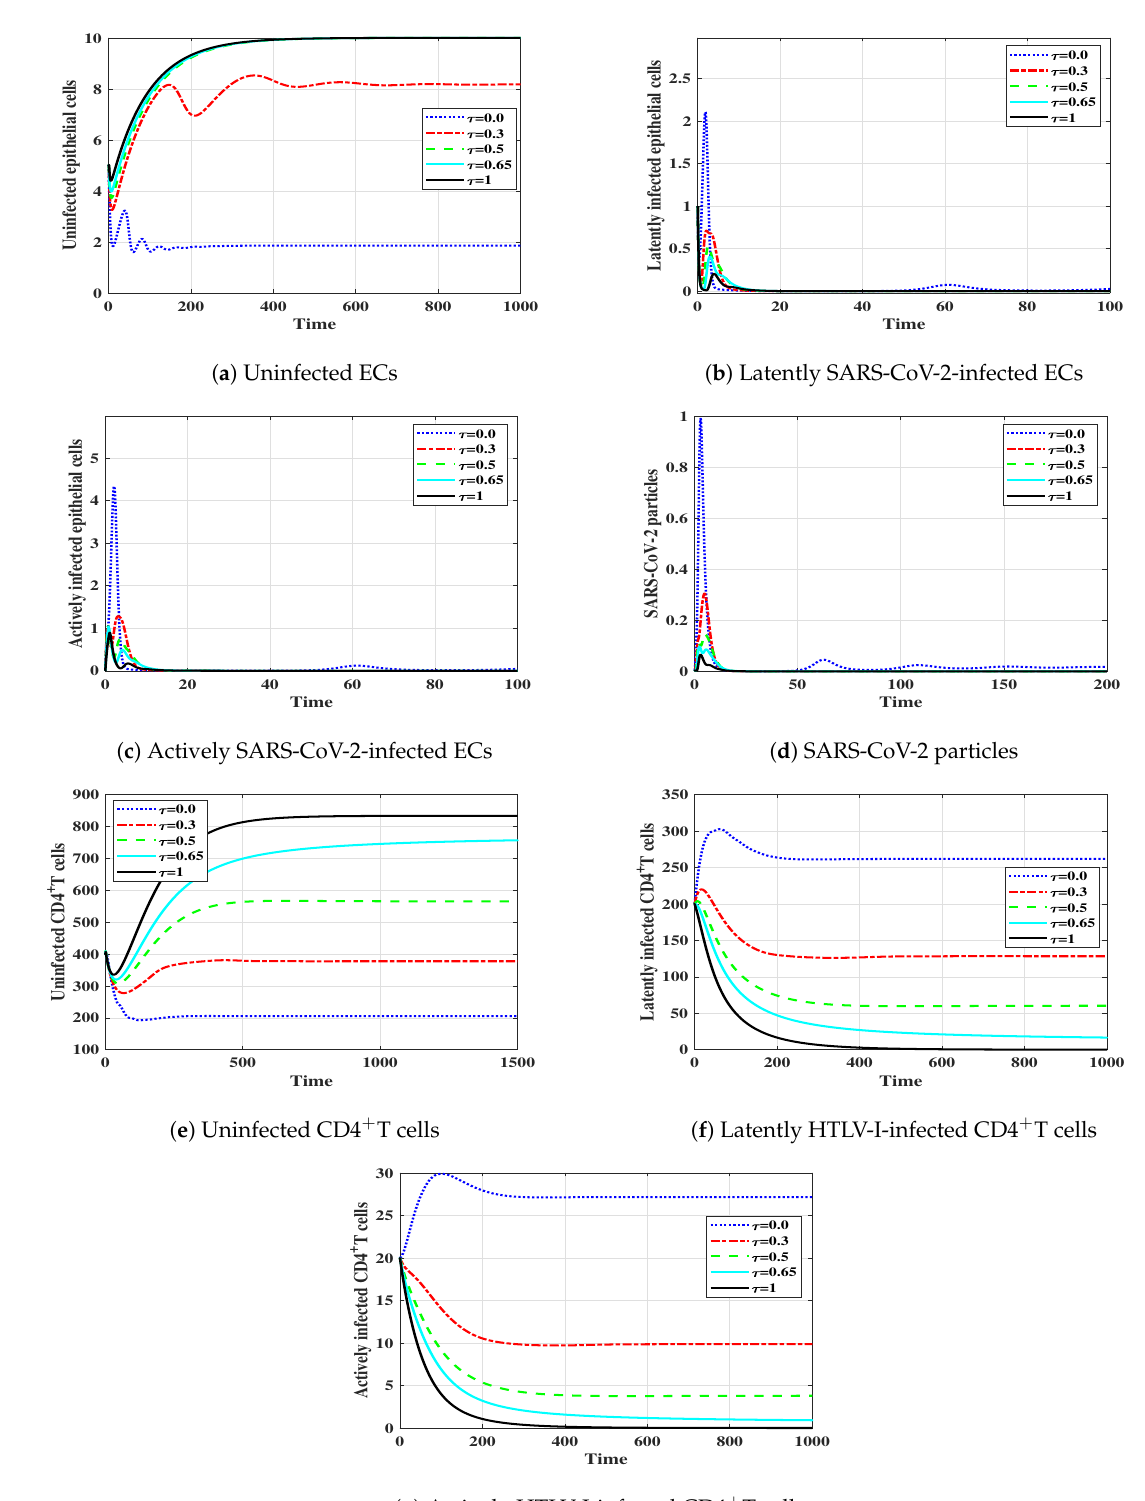
Figure 5. Impact of time delays parameters τ i , i = 1,2,3,4,5 on the HTLV-I/SARS-COV-2 coinfection’s dynamics given by system (7)–(13) with initial conditions